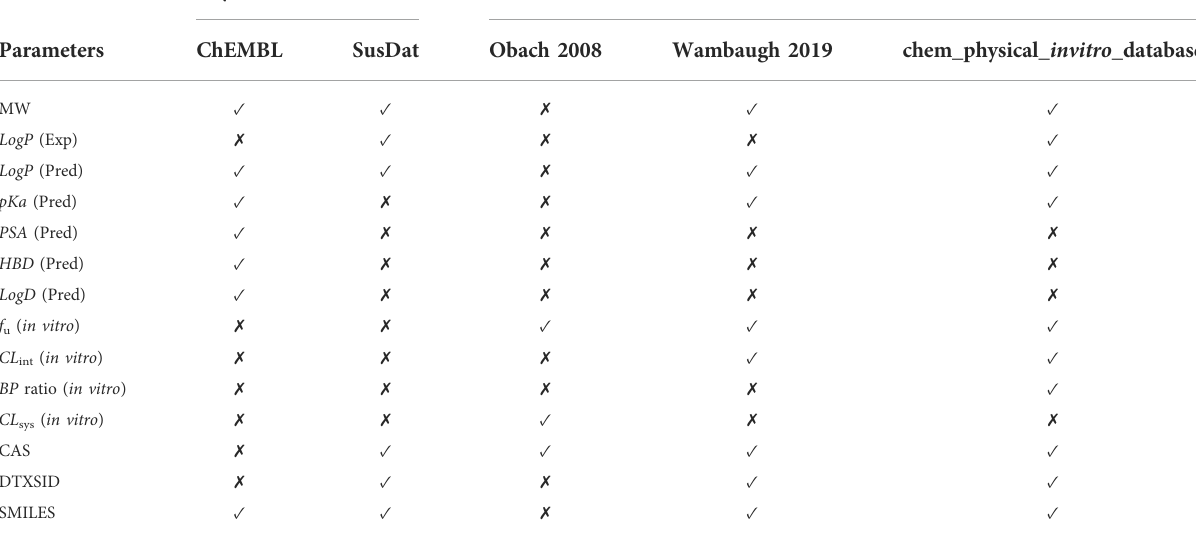
TABLE 1 Parameters which are extracted from the Physicochemical Databases and httk Databases. “ (Pred) ” refers to predicted values and “ (Exp) ” referstoexperimentalvalues.Acheckmark( ✓ )denotesthepresenceoftheparameterinthedatabase,whilstacrossmark( 7 )denotestheabsence of the parameter from the database.